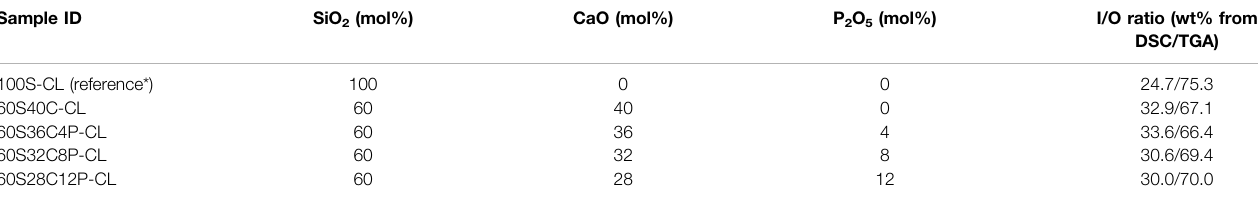
TABLE 1 | Nominal compositions of the inorganic component SiO 2 -CaO-P 2 O 5 /PTHF/PCL-diCOOH, produced by the substitution of SiO 2 -CaO-P 2 O 5 for SiO 2 in the SiO 2 / PTHF/PCL-diCOOHhybridsystemdevelopedbyTallia etal. (Talliaetal.,2018),andinorganic/organicratiodeterminedbyDSC/TGA.Allhybridcompositionsweremade starting from TEOS/PCL-diCOOH of 80/20 wt%, to which CME and TEP were added in order to obtain the corresponding SiO 2 /CaO/P 2 O 5 molar composition in the inorganic component. The reference composition 100S-CL (*) is the Ca-free and P-free hybrid composition. Sample